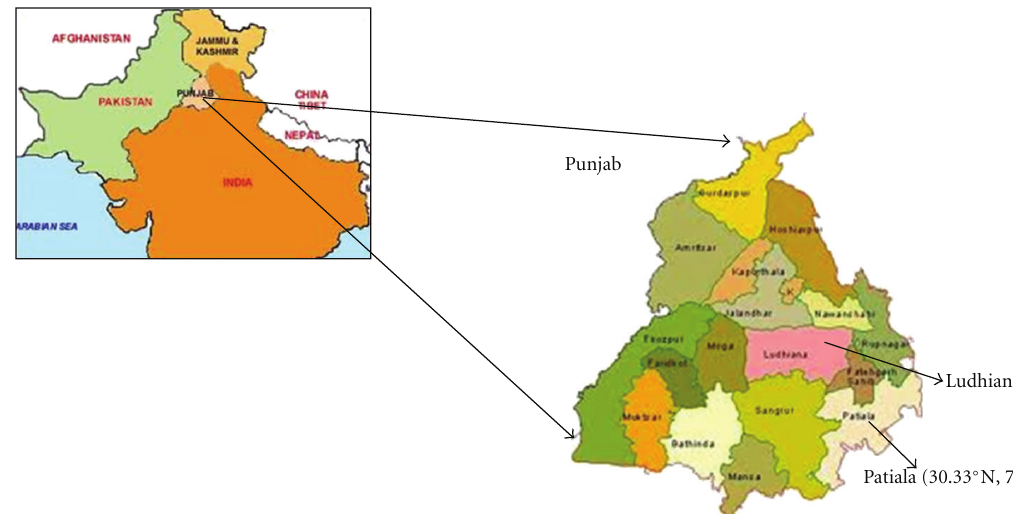
Figure 1: Site map for Patiala city (30.33 ◦ N, 76.4 ◦ E, 249m a.s.l) in northwestern